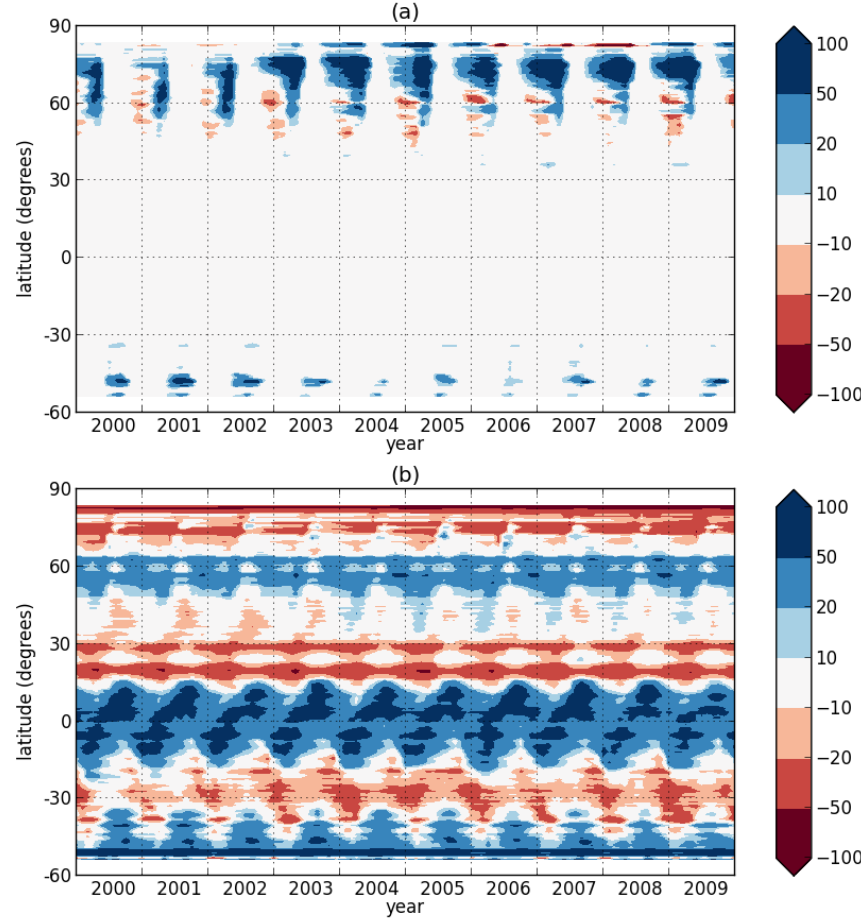
Figure 5. As Fig. 4, but for the difference between ERA-Interim/Land and ERA-Interim in (a) SWE (kgm − 2 ) and (b) TCSM (kgm − 2 ).